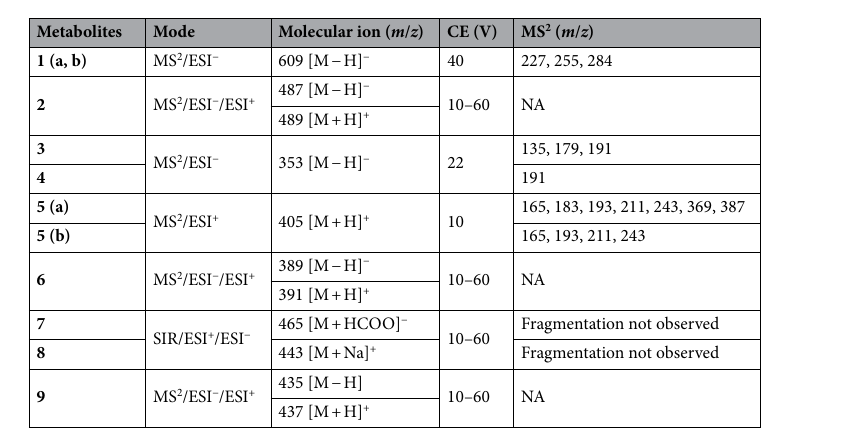
Figure 2. An overview of major metabolites explored in the leaf tissue of Citronella gongonha Mart . (Cardiopteridaceae). Metabolites: 1a, b , kaempferol-3- O -dihexoside; 2 , caffeoyl glucoside; 3 , 3- O -caffeoylquinic acid; 4 , 5- O -caffeoylquinic acid; 5 , kingiside; 6 , 8-epi-kingisidic acid; 7 , (7 α )-7- O -methylmorroniside; 8 , (7 β )- 7- O -methylmorroniside; 9 , alpigenoside. Chemical structures were produced in ChemDraw Ultra v12.0.2.1076 software package (https:// www. cambr idges oft. com).